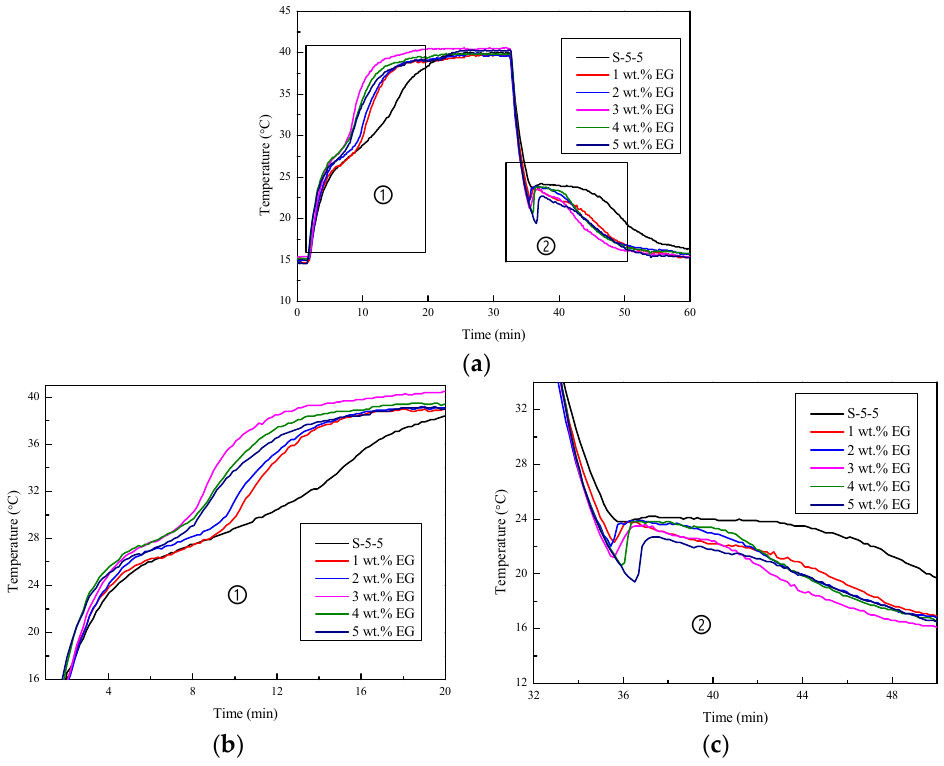
Figure 11. Cooling curves of Na 2 SO 4 · 10H 2 O composites with varying contents of EG: ( a ) whole cooling curves; ( b ) enlargement of the heating process; ( c ) enlargement of the cooling process.